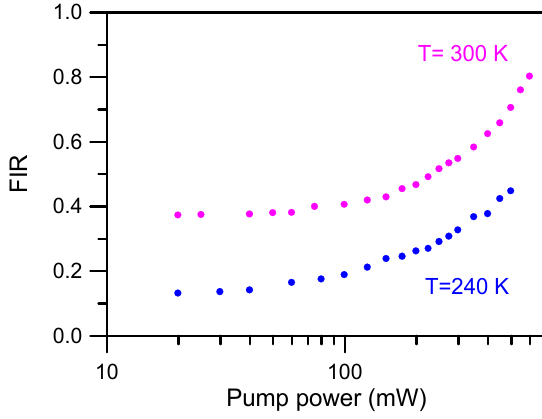
Figure 7. Fluorescence intensity ratio as a function of pumping power at two different temperatures.